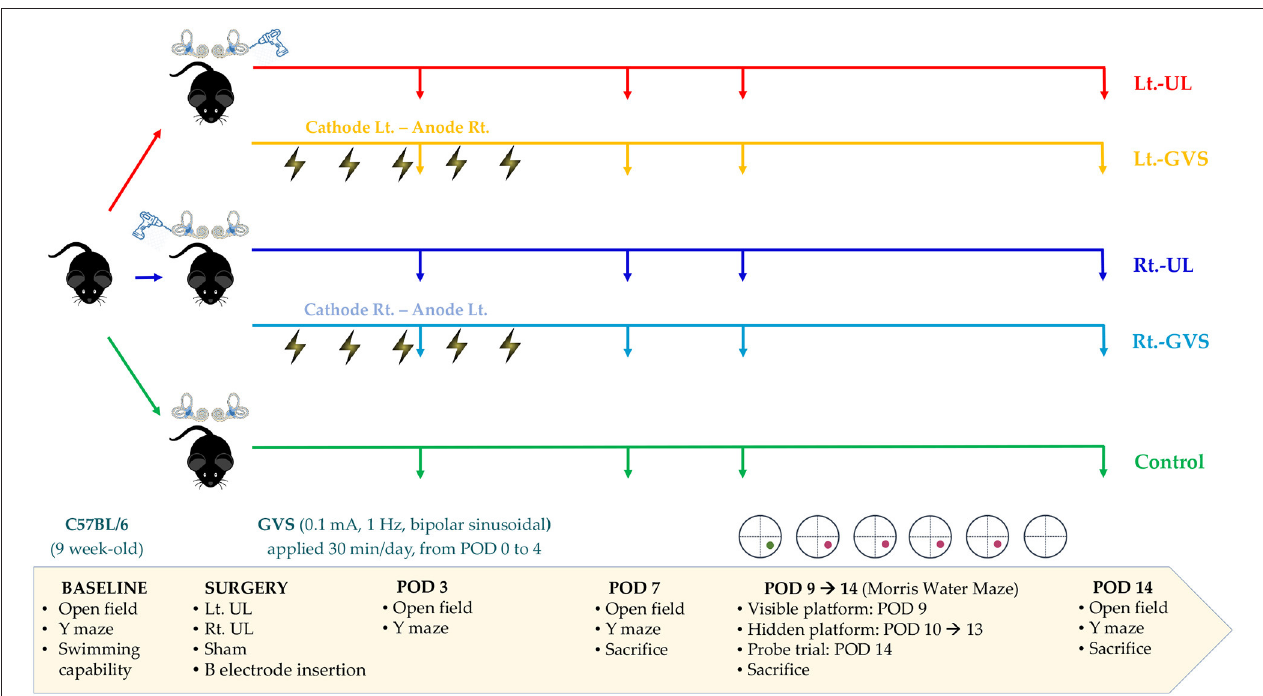
FIGURE 1 | A schematic representation of the experimental design. Lt, left-sided; Rt, right-sided; UL, unilateral labyrinthectomy; GVS, galvanic vestibular stimulation; POD, postoperative